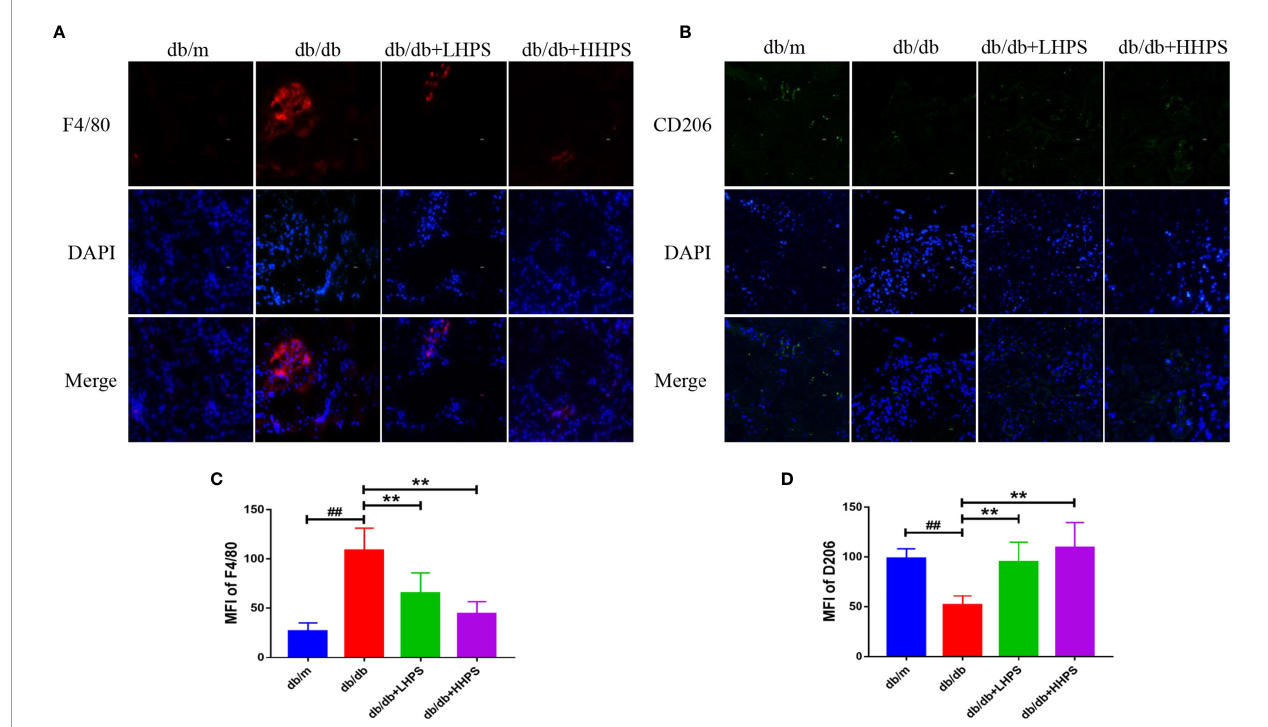
FIGURE 5 | The M2 macrophage polarization in the kidney of db/db mice treated with Hyperoside. Immuno fl uorescence staining showed that Hyperoside promoted the polarization of M2 macrophages and reduced total number of macrophages in the kidney. (A) Macrophages were stained for F4/80 (red) in glomeruli of db/db mice by immuno fl uorescence after Hyperoside treatment. (B) M2 macrophages were stained for CD206 (green) in glomeruli of db/db mice by immuno fl uorescence. DAPI was used to stain the cellular nucleus. (Original magni fi cation: × 400. Scale bars = 50 m m). Shown is also quanti fi cation of F4/80 (C) and CD206 expression (D) , as presented as MFI. (n=5 per group, ## P < 0.01 vs db/m ; ** P < 0.01 vs db/db